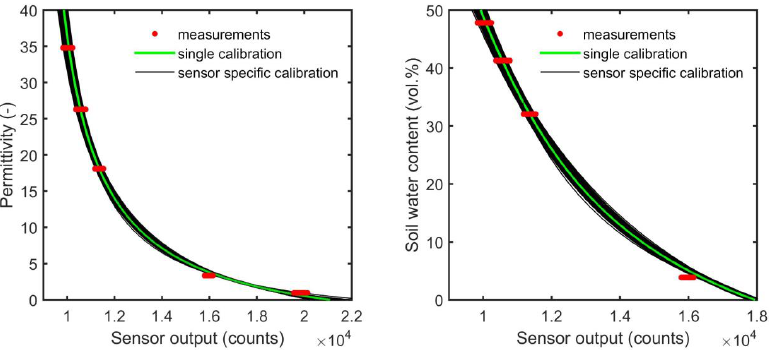
Figure 7. Sensor-specific calibration curves fitted to the sensor response measurements of each of the 701 SMT100 sensors, as well as the single calibration curve fitted to the whole data set of every sensor type (left and right panels are presenting permittivity and equivalent soil water content values, respectively).